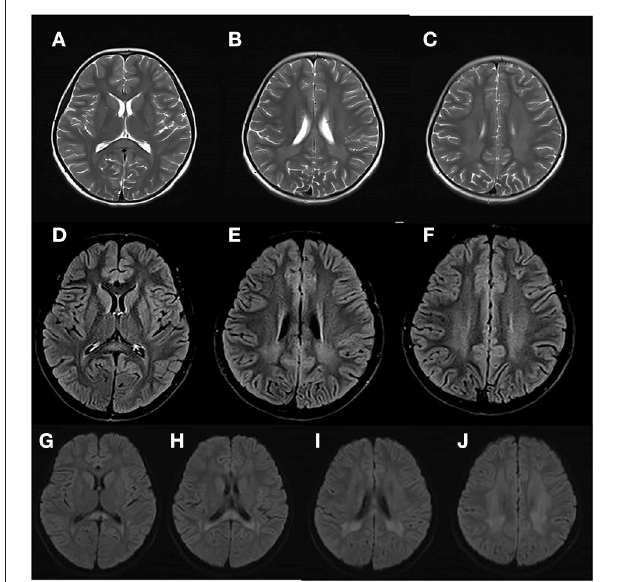
FIGURE 1 | Brain MRI of the patient at her first episode of disease, at 8 years and 9 months. The white matter (WM) showed hyperintense in